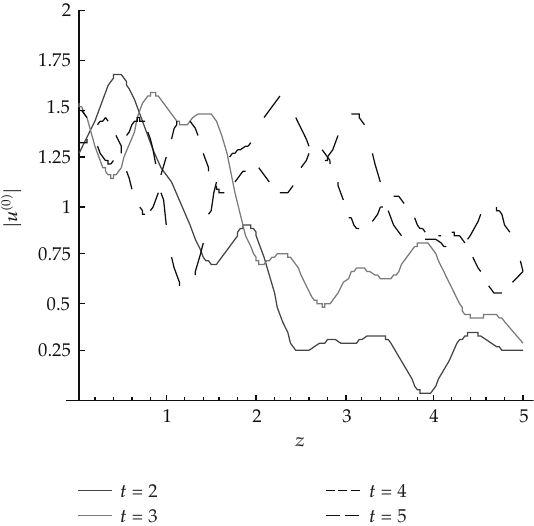
Figure 12: The zero-order approximation | u (cid:3) 0 (cid:4) | at α (cid:8) 1, T (cid:8) 10, γ (cid:8) 02 for di ff erent values of t , considering only one term in the series (cid:3) M (cid:8) 1 (cid:4) .